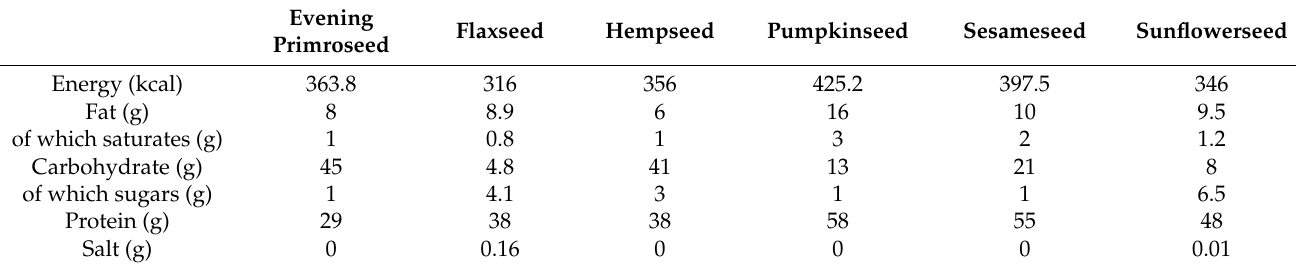
Table 6. Chemical composition of selected oilseed flours (in 100 g of the